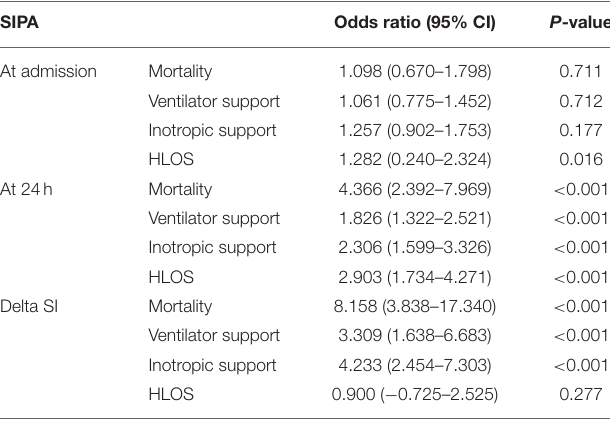
TABLE 4 | Logistic regression analysis of the association of SIPA to clinical outcomes after adjusting confounding factors.